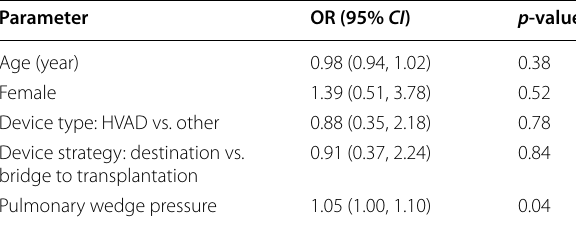
Table 7 Parameters associated with postoperative RHF